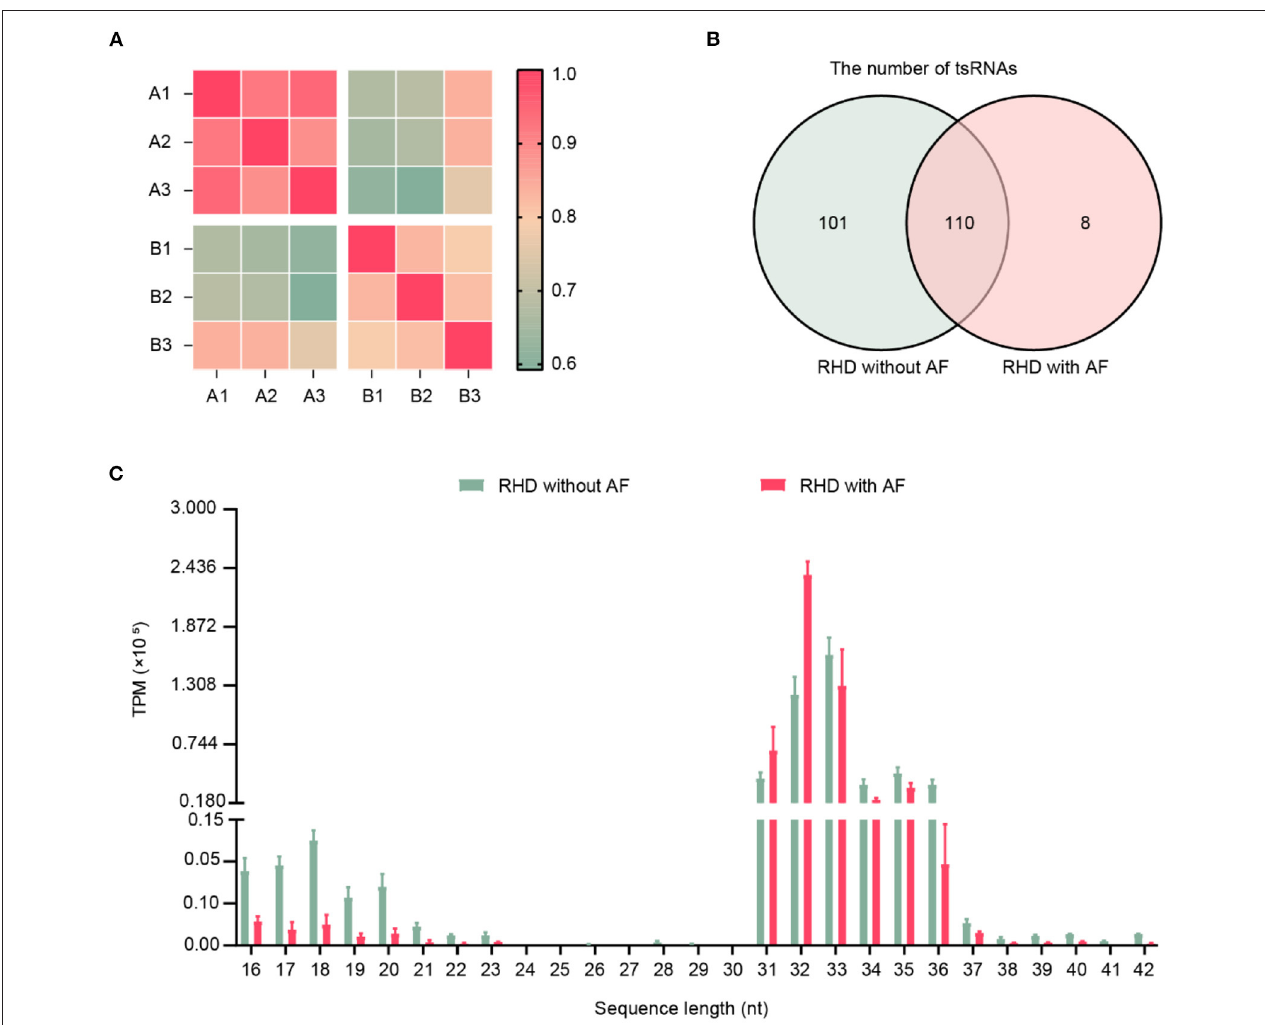
FIGURE 1 | Expression profiles of tRFs/tiRNAs sequencing data in RHD with AF and RHD without AF. (A) The correlation coefficient was applied to evaluate the criterion of reliability, and it is reasonable for the sample selection (RHD without AF: A1, A2, A3; RHD with AF: B1, B2, B3). (B) Venn plot displayed the total number of identified tsRNAs in RHD with the AF group and RHD without the AF group. (C) Length distributions of tsRNA in the RHD without AF and RHD with AF (TPM: tsRNA expression levels normalized as tag counts per million of total aligned tRNA reads).